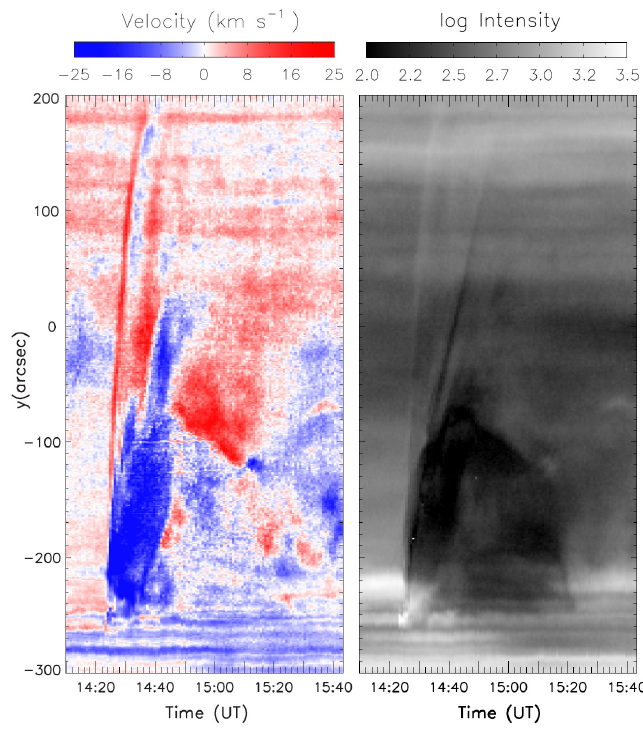
Figure 29: Spectroscopic observations of the coronal wave of 2011 Feb 16 with Hinode/EIS. Shown are stack plots of the Doppler velocity ( left ) and intensity ( right ) derived from the Fe xiii line (202 ˚A). Note that the fast redshifted feature starting around 14:25 UT is correlated with a bright feature that corresponds to the coronal wave. Image reproduced with permission from Veronig et al. (2011), copyright by